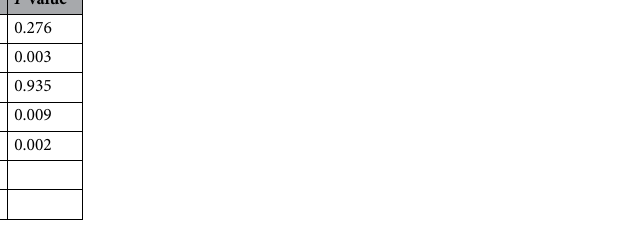
Table 5. ANOVA for compressive strength.